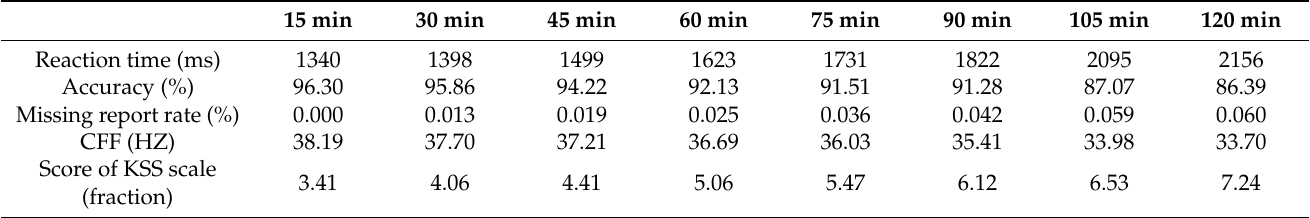
Table 13. Mean values of each component in the two-hour CPT task.